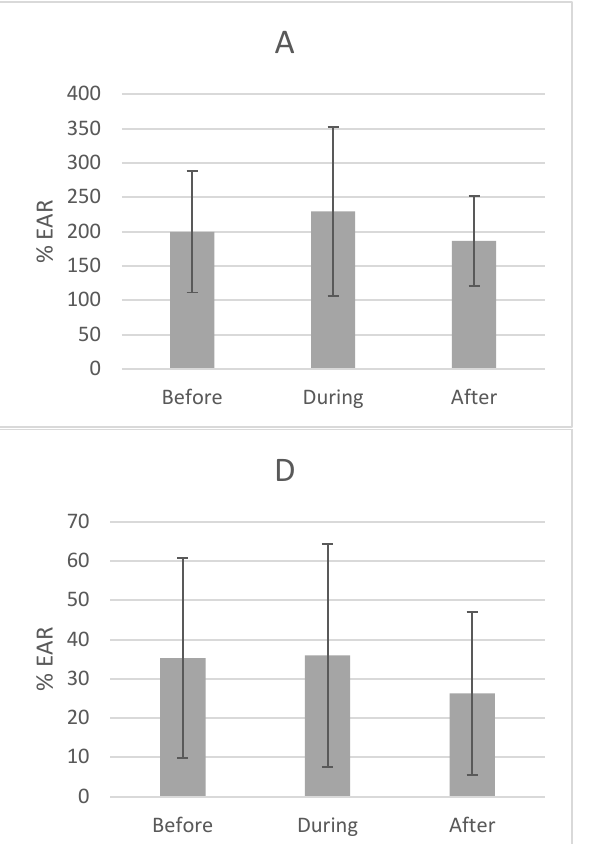
Before During After Before During After Figure 2. Mean ± standard deviation of vitamin intake in the three stages of the study. Figure 2. Mean ± standard deviation of vitamin intake in the three stages of the study. Figure 2. Mean ± standard deviation of vitamin intake in the three stages of the study.